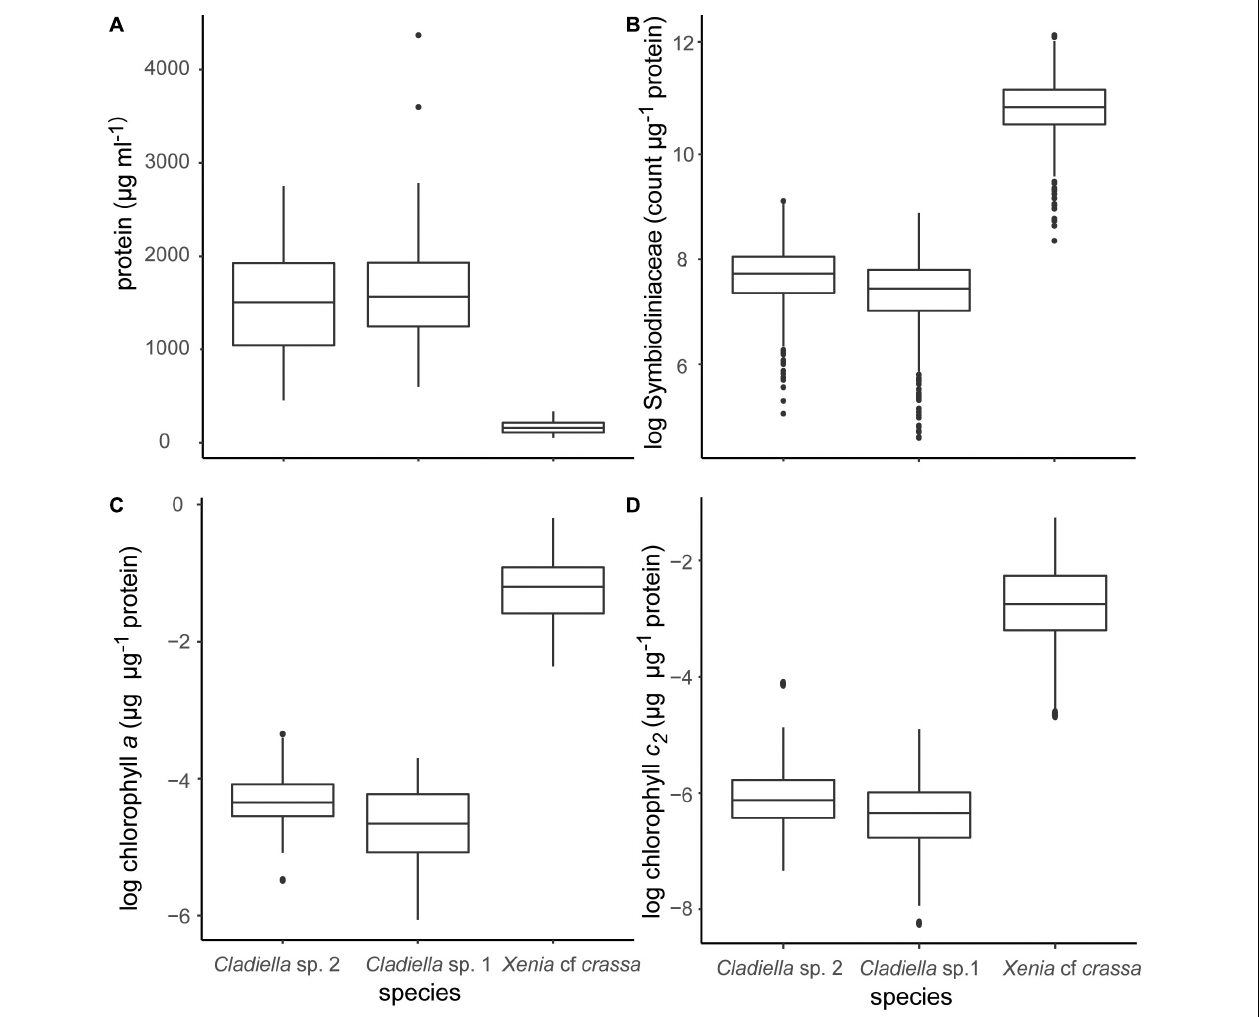
FIGURE 1 | Boxplots of data generated using the method described in this manuscript. (A) µ g protein per ml, (B) Symbiodiniaceae cell per µ g protein, (C) chlorophyll a per µ g protein, and (D) chlorophyll c 2 per µ g protein. Symbiodiniaceae and chlorophyll concentrations were log transformed for plotting to improve the readability of